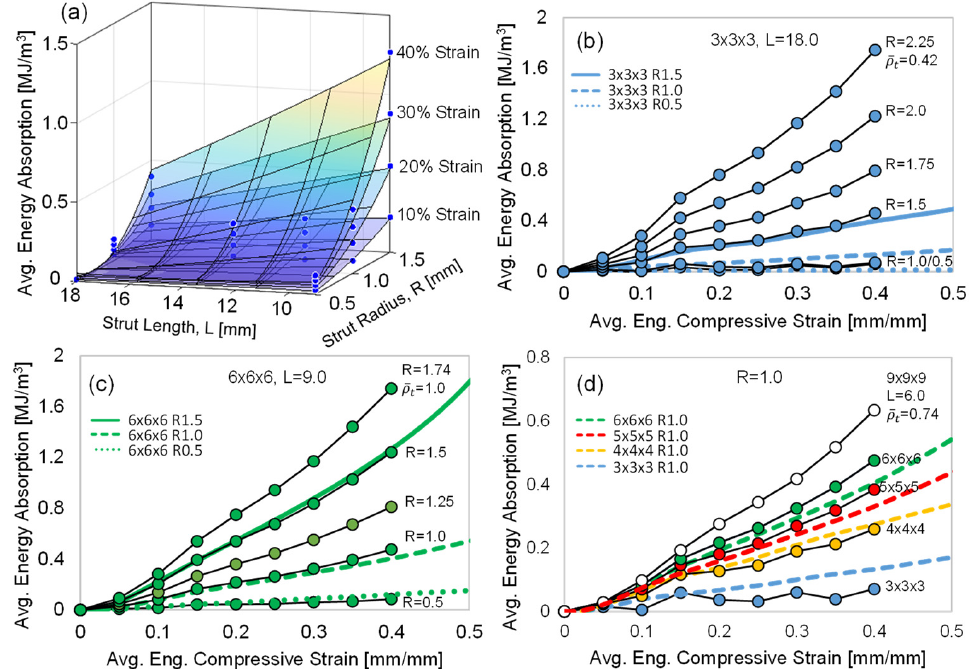
Figure 13. ( a ) A plot of Equation (3) for various compressive strain increments. The circular data points represent the experimental data. The predicted and measured energy absorption curves for ( b ) 3 × 3 × 3, L = 18.0; ( c ) 6 × 6 × 6, L = 9.0; and ( d ) R = 1.0, various L (unit cell density). The circular data points in ( b – d ) are predicted, and the continuous curves are the measured data. Table 2. The polynomial constants used in equation 4.